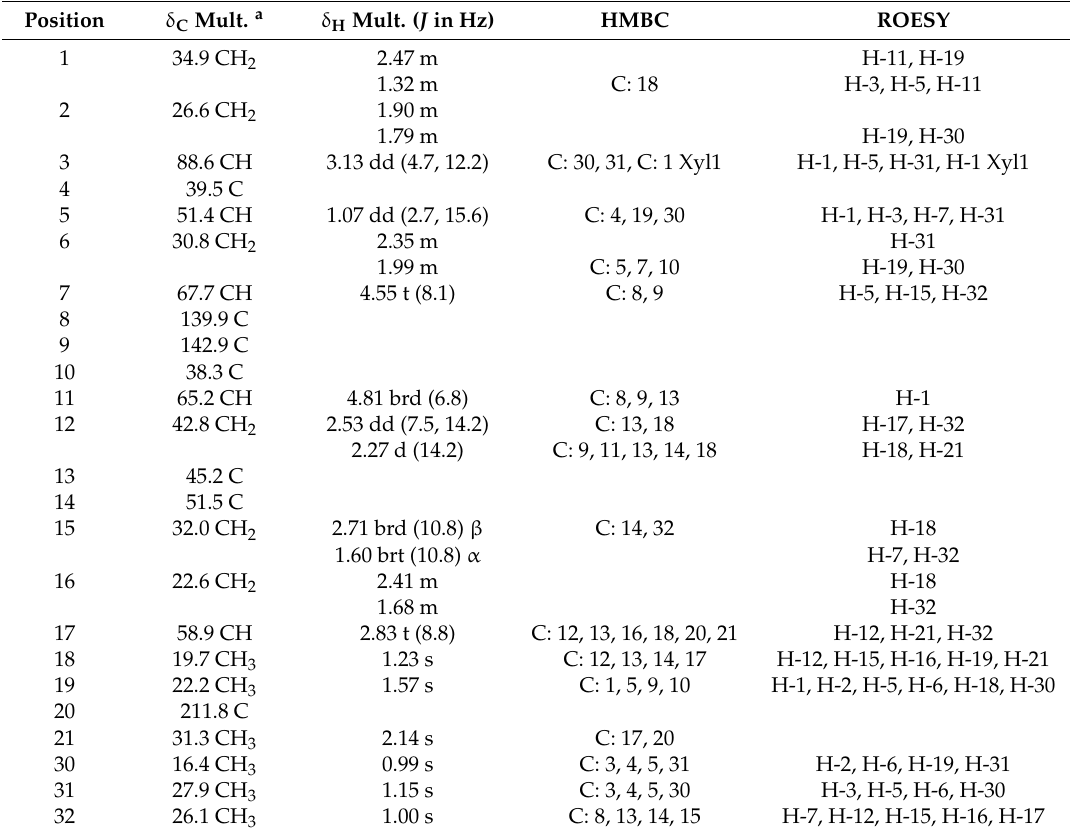
Table 2. NMR Spectroscopic data (700 MHz, C 5 D 5 N/D 2 O (4/1 v / v )) of the aglycone moiety of fallaxoside D 4 ( 1